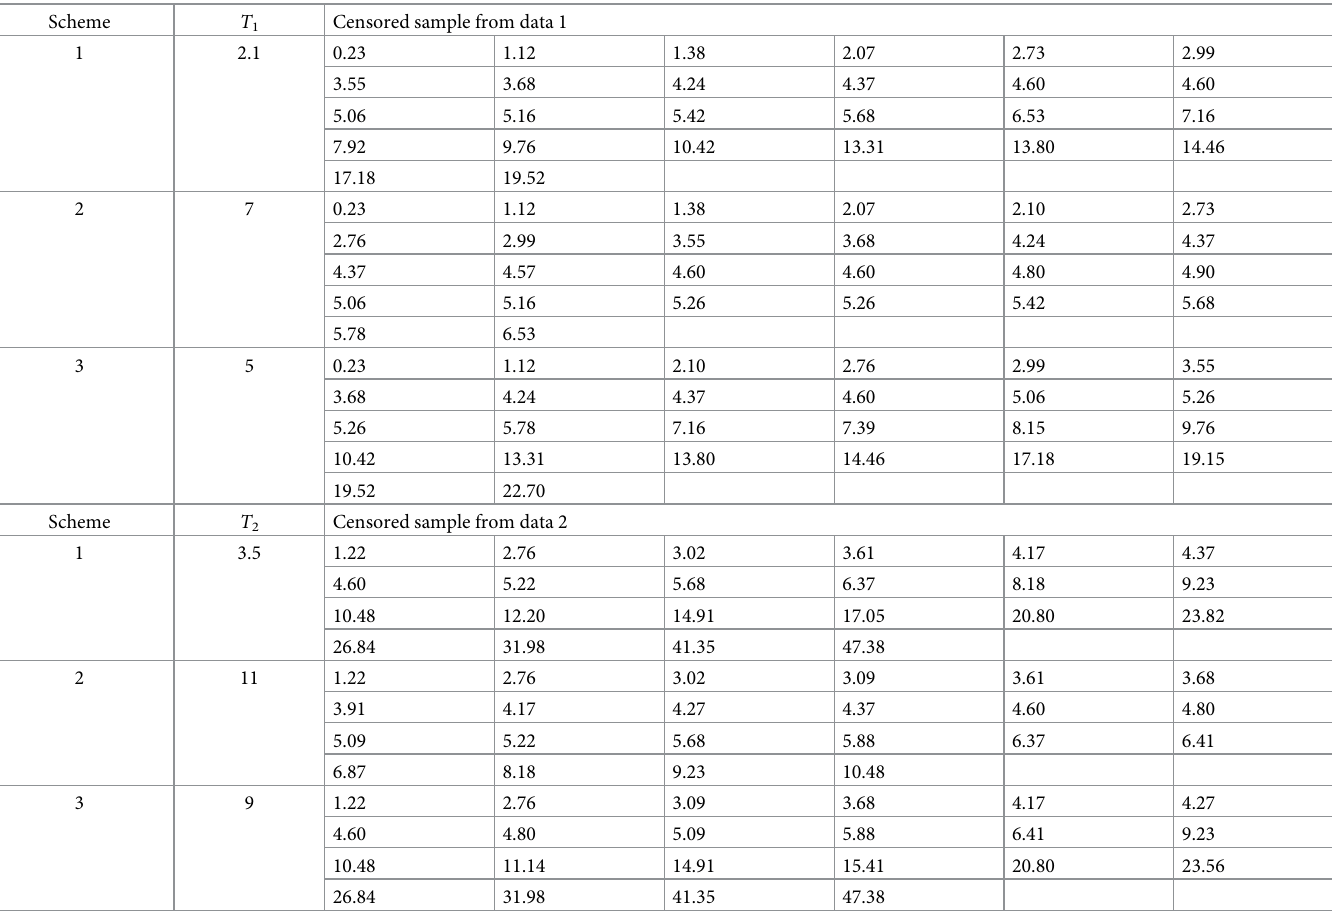
Table 18. Adaptive type-II censored samples form data 1 and data 2. Scheme